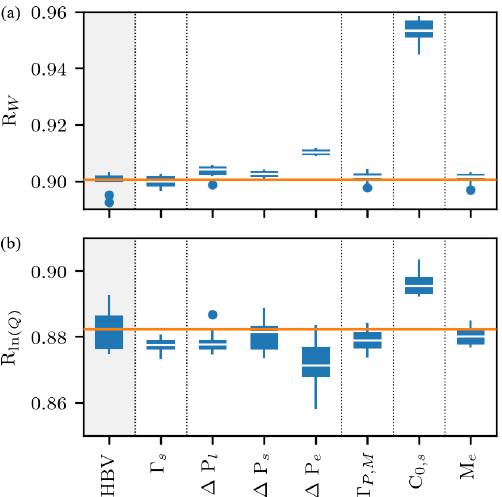
Figure 3. Model calibration performance for the 10 calibration ef- forts against the two objective functions ( a : snow water equiva- lent; b : logarithmic stream runoff) for each of the modifications to individual components of the snow routine of the HBV model for the Allenbach catchment at Adelboden (CH-204). The modifi- cations include a seasonally variable temperature lapse rate ( (cid:48) s ), a linear, sinusoidal, and exponential function for the precipitation phase partition ( (cid:49)P l , (cid:49)P s , and (cid:49)P e respectively), different thresh- olds for precipitation phase and snowmelt ( T P , M ), a seasonally vari- able degree-day factor ( C 0 , s ), and an exponential snowmelt with no refreezing ( M e ). The median performance of HBV is represented with an orange horizontal